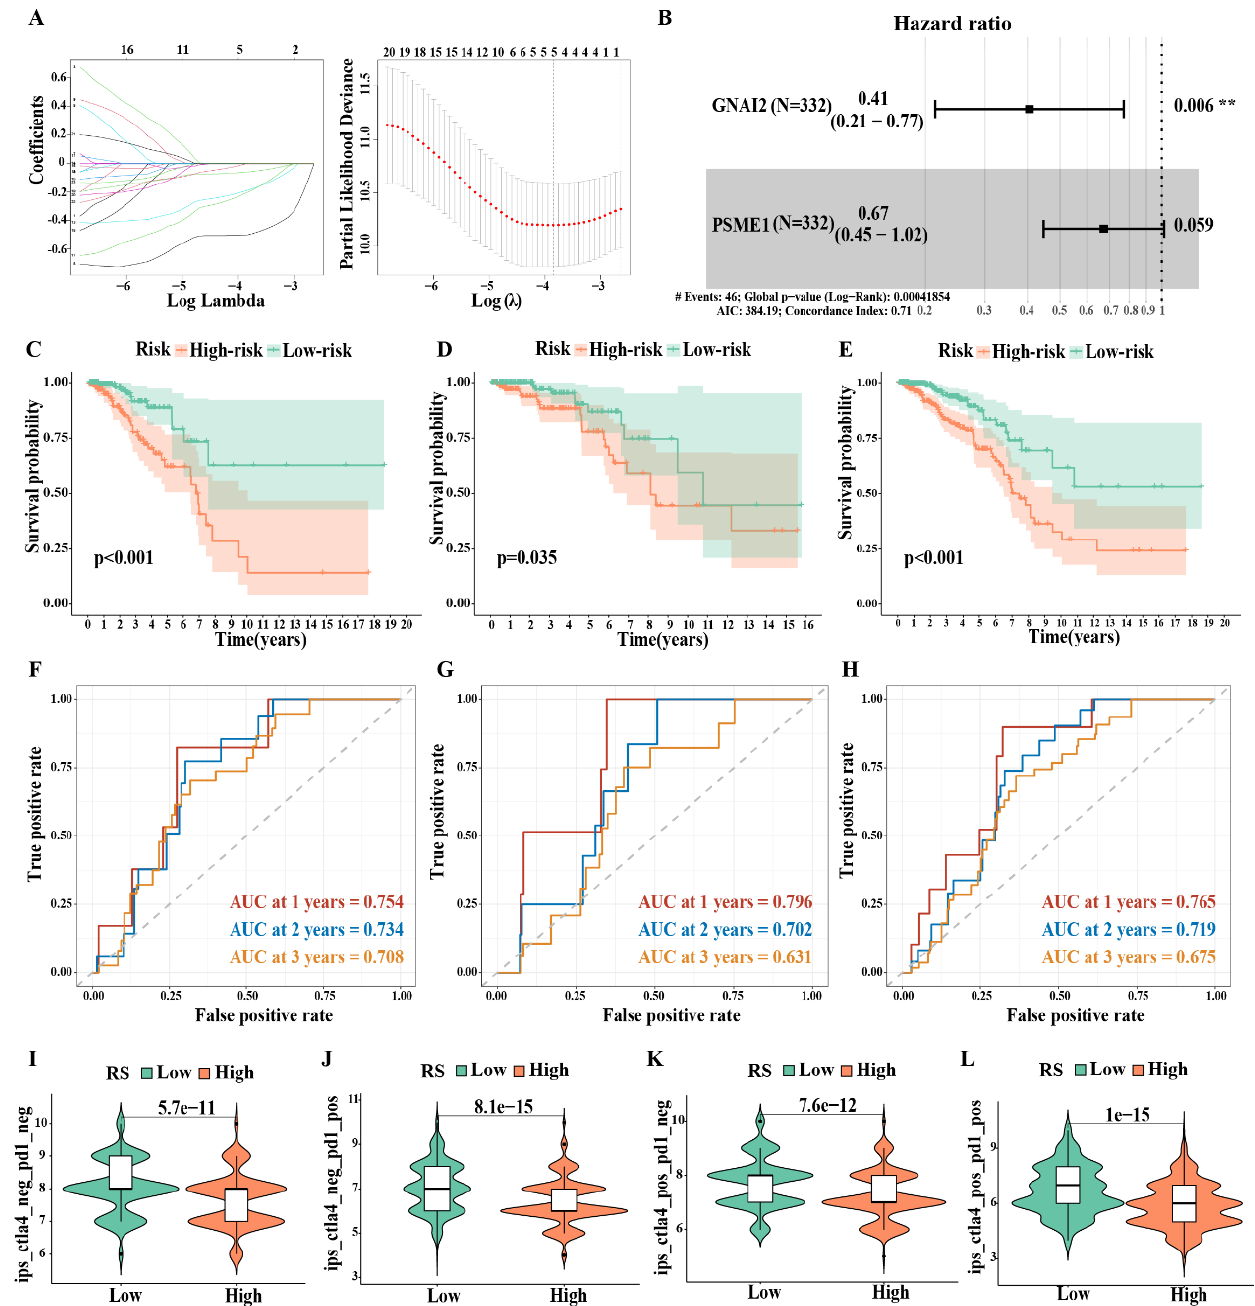
Figure 8. Risk model of IDC based on FerrS − ImmS related genes: ( A ) Lasso regression analysis. ( B ) Multivariate COX analysis. ( C – E ) Kaplan – Meier overall survival curves for patients in high − and low − risk groups of the Train group ( C ), Test group ( D ), and ALL group ( E ). ( F – H ) Time − dependent ROC curves at 1, 2, 3 years for patients in the Train group ( F ), Test group ( G ), and ALL group ( H ) to evaluate the prediction efficiency of the prognostic signature. ( I – L ) Immunotherapy sensitivity analysis between high − and low − risk groups. (** p < 0.01).